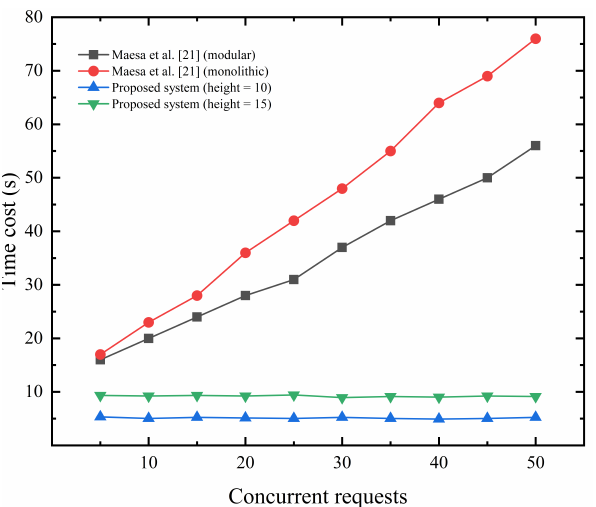
Figure 9. On-chain computation time cost (s) for system of Maesa et al. [21] and ours in the low- traffic